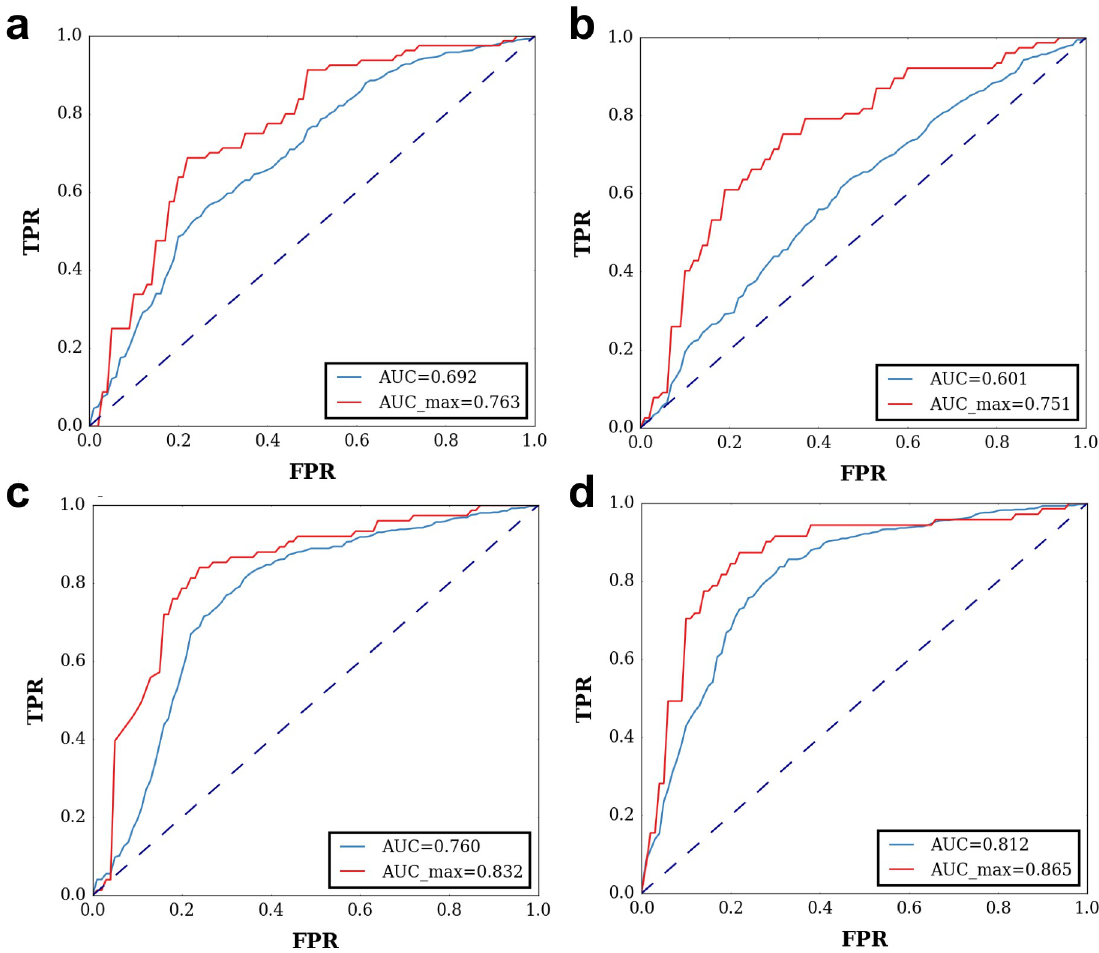
Fig 8. ROC curves for disease prediction performance comparing Seq-GNM, experimental B-factors and evolutionary parameters. ROC curves are plotted using 10 randomly selected training and testing data sets using 80%, and 20% of the data, respectively. (a) ROC curve of Seq-GNM. (b) ROC curve of experimental B-factors. (c) ROC curve of evolutionary parameters, where primate, mammal, and vertebrate fitch rates using Fitch Algorithm [57]; and Entropy2 are used as features for training. (d) ROC curve of evolutionary parameters used in (c) with the addition of